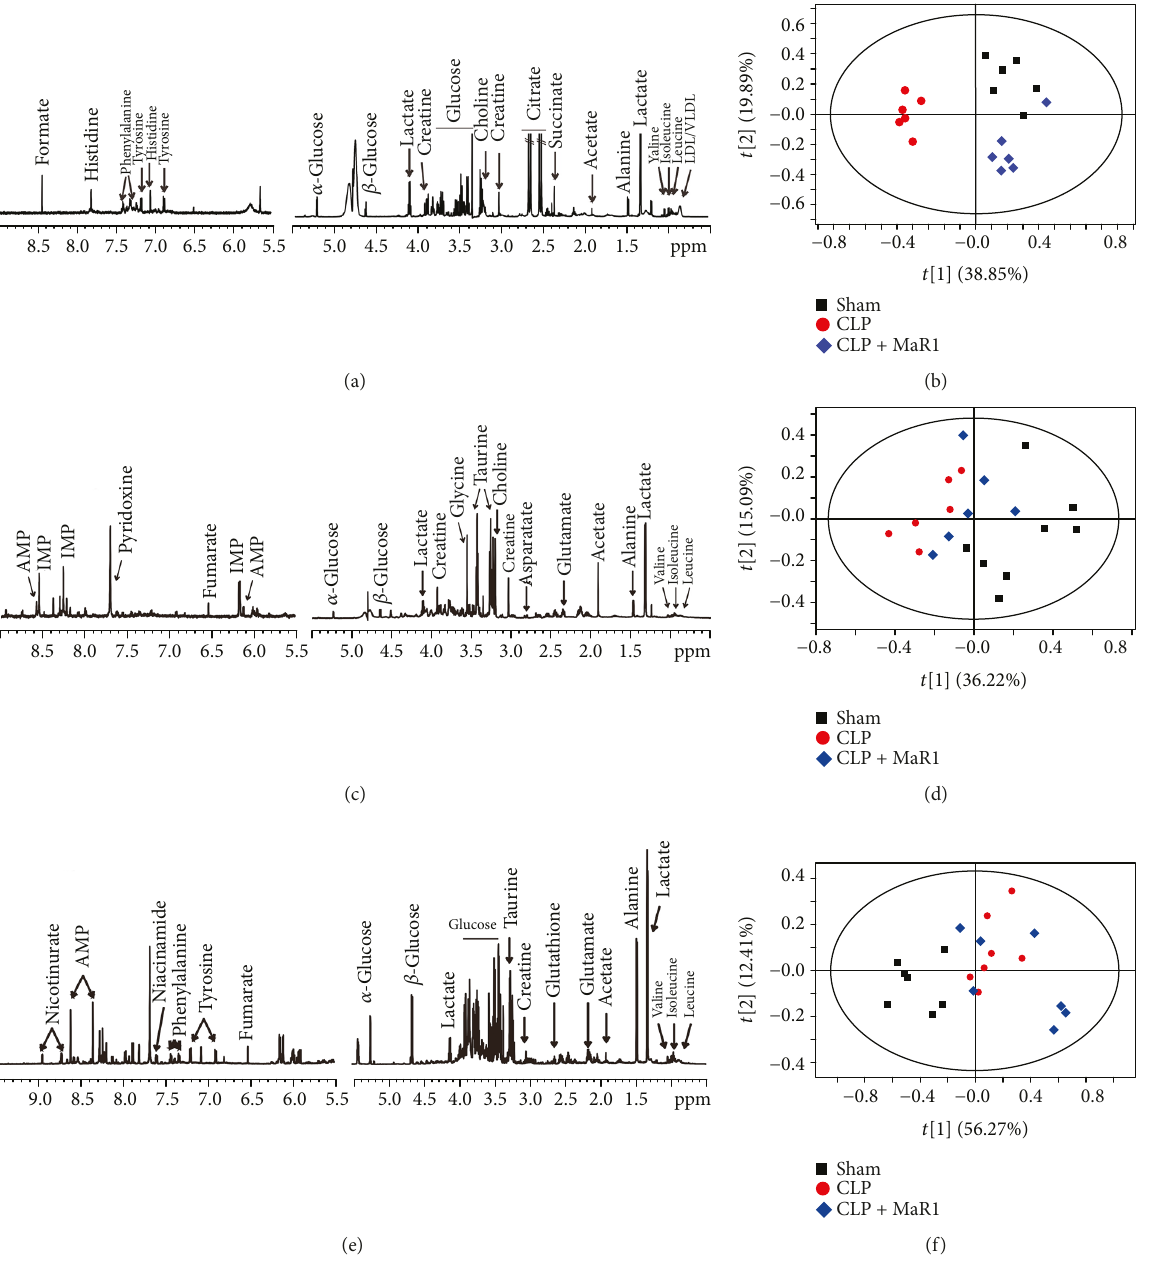
Figure 5: 1 H-NMR-based metabolic pro fi les patterns in septic mouse treatment with MaR1. Representative 1 H NMR spectra of serum (a), lung (c), and liver (e) samples obtained from the mice, respectively. The PCA score plot based on the 1H NMR spectra of serum (b), lung (d), and liver (f) samples obtained from mice of three experimental